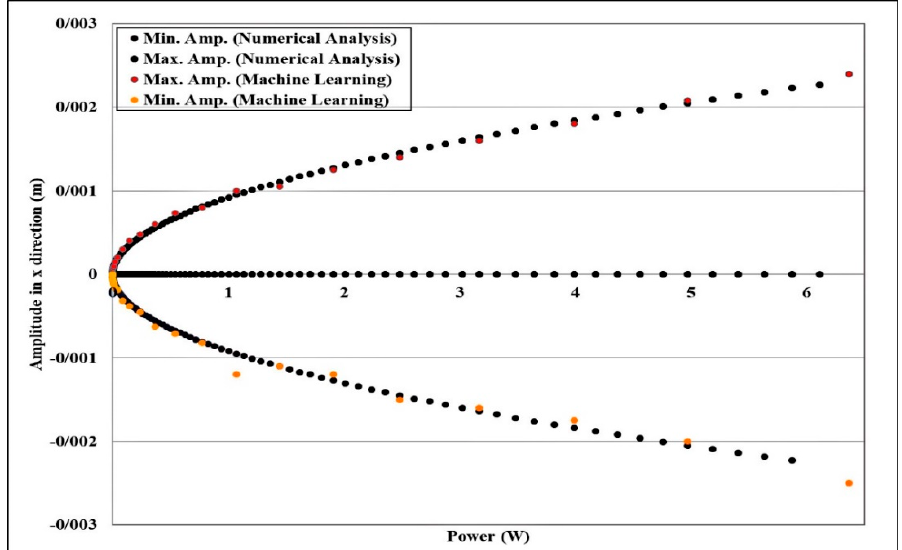
Figure 10. The effect of increasing the produced power on the amplitude of vibration.